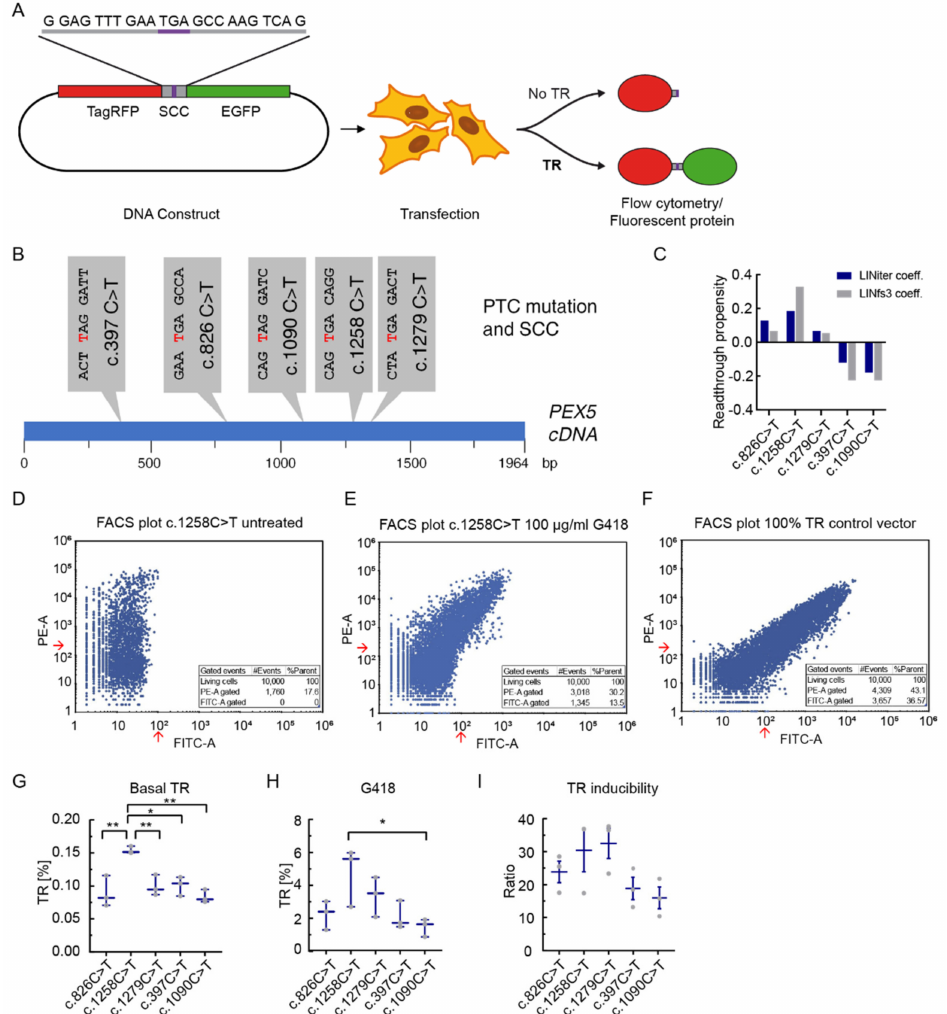
Figure 1. The SCC affects basal and induced translational readthrough. ( A ) Dual reporter TR assay. The vector contains an SCC between an RFP- and a GFP-sequence. TR is assessed by flow cytometry after transfection. ( B ) PEX5 SCCs analyzed in this study. The mutated nucleotide resulting in PTC is shown in red. ( C ) TR propensity values for the five SCCs was predicted according to LINiter and LINfs3 model from [20]. ( D – F ) Representative FACS plot and table of events per gate. Red arrows: Gates for TR were 220 for RFP (‘PE-A’) and 100 for GFP (‘FITC-A’). 10,000 events were recorded per measurement. ( G ) Flow cytometry-based dual reporter assay of PEX5 -SCCs shows that basal TR differs between different SSCs. ( H ) G418 is a potent TRID and induces significant levels of TR in all SCCs at a concentration of 100 µ g/mL (Ordinary one-way ANOVA, Tukey’s multiple comparisons test induced vs. basal TR: c.826C>T: p = 0.026, c.1258C>T: p = 0.00024, c.1279C>T: p = 0.021, c.397C>T: p = 0.00022, c.1090C>T: p = 0.025). TR induction depends on the SCC and differs between the